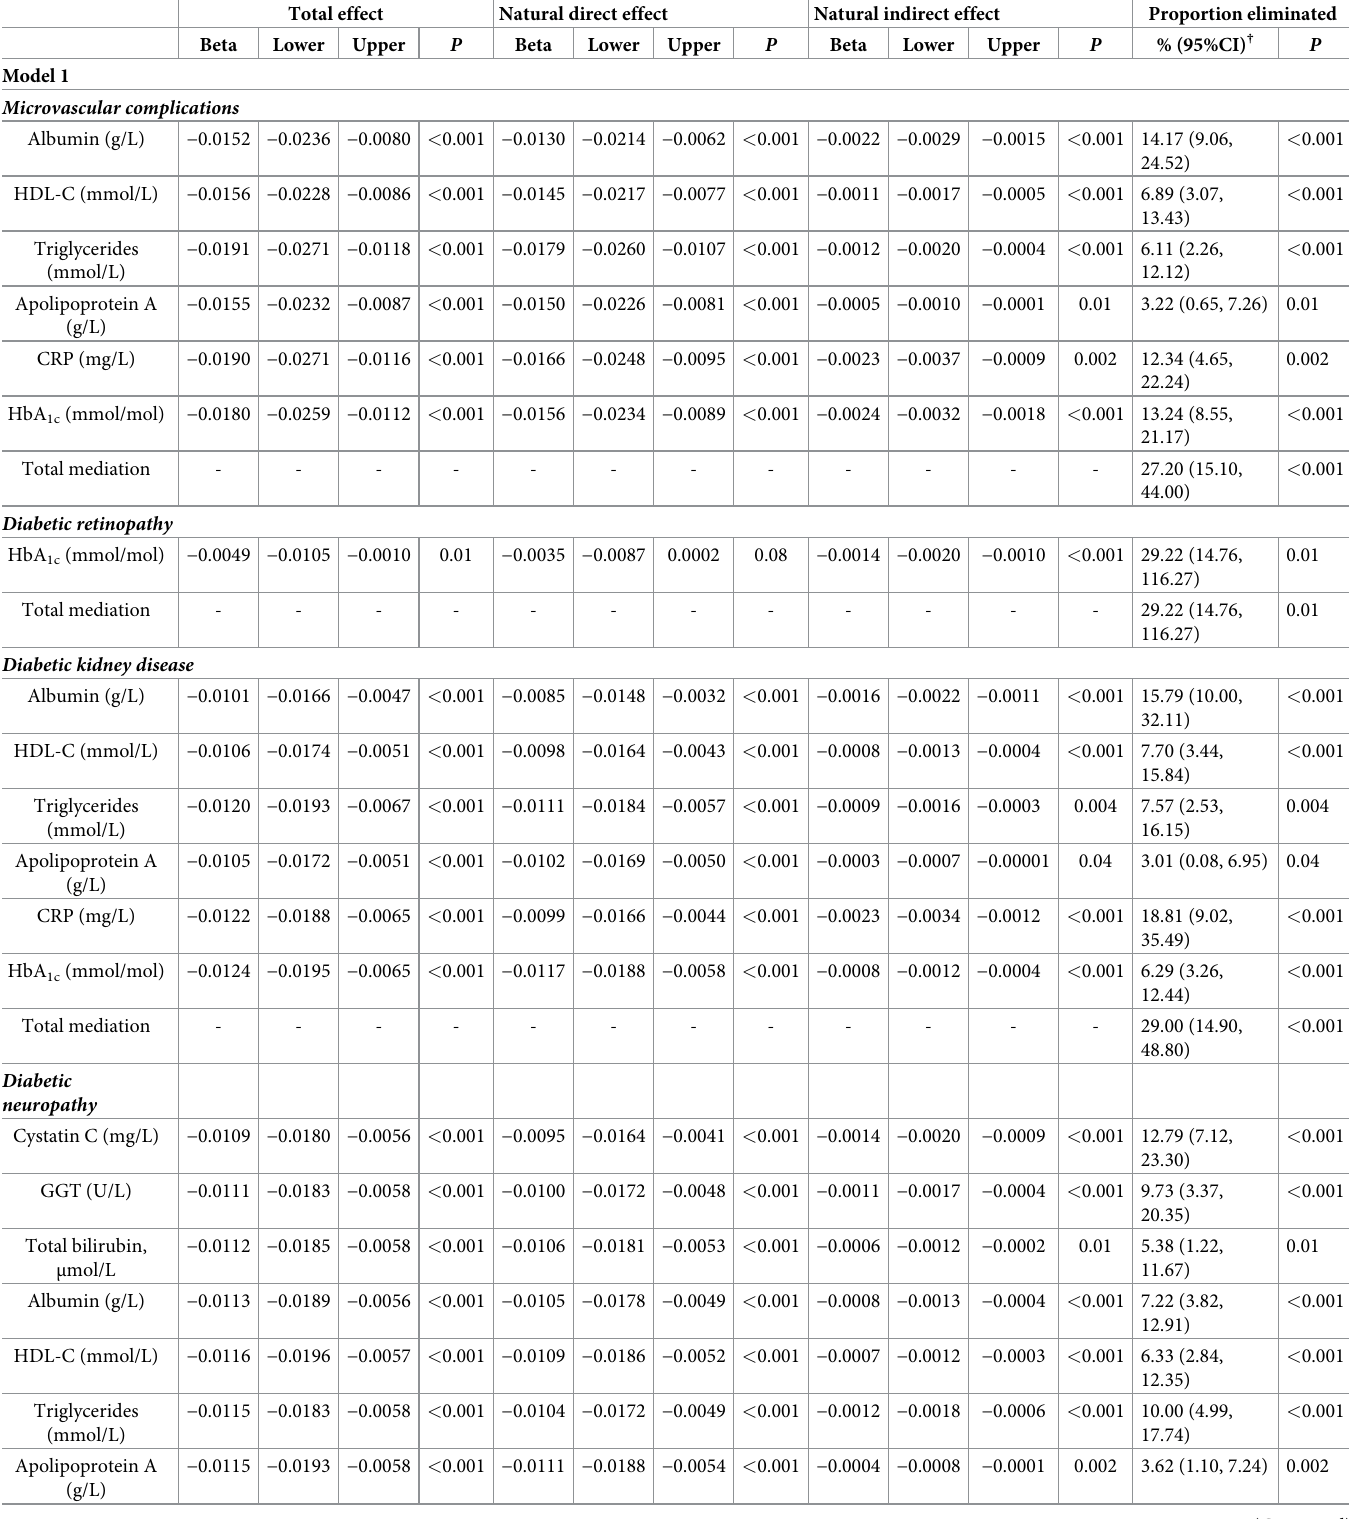
Table 3. Association of healthy lifestyle scores with microvascular complications mediated by biomarkers among individuals with T2D �